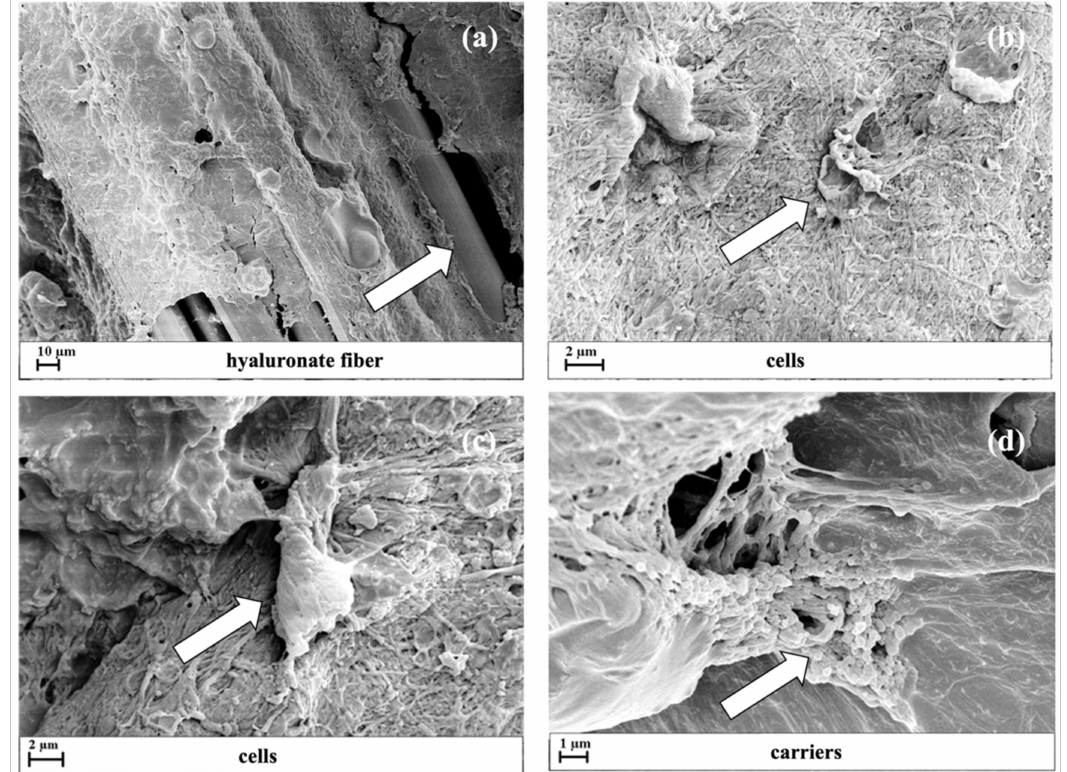
Figure 4. 3D scaffold structure monitored by FE-SEM images after its assembly. FE-SEM images were reported with different enlargements to better describe: the hyaluronate fibers covered by the fibrin hydrogel ( a ); the cells (see arrowheads) entrapped within the fibrin matrix in large aggregates connected with fibrin network ( b , c ); NCs distributed within the fibrin network ( d